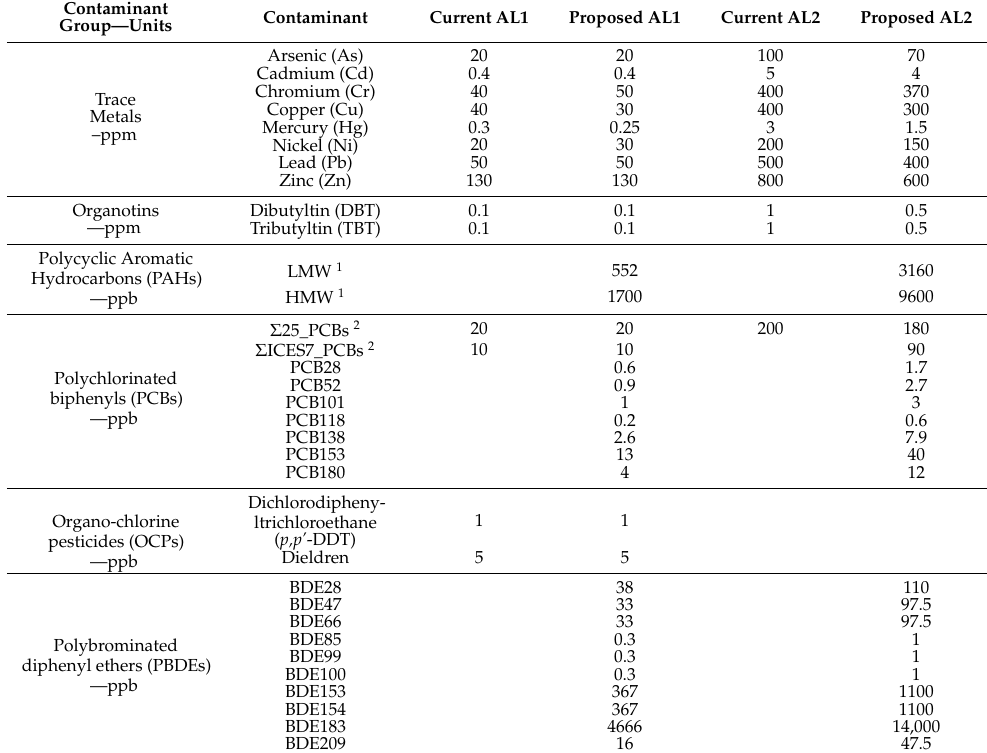
Table 20. Proposed action levels for all determinants tested, including the current action levels for